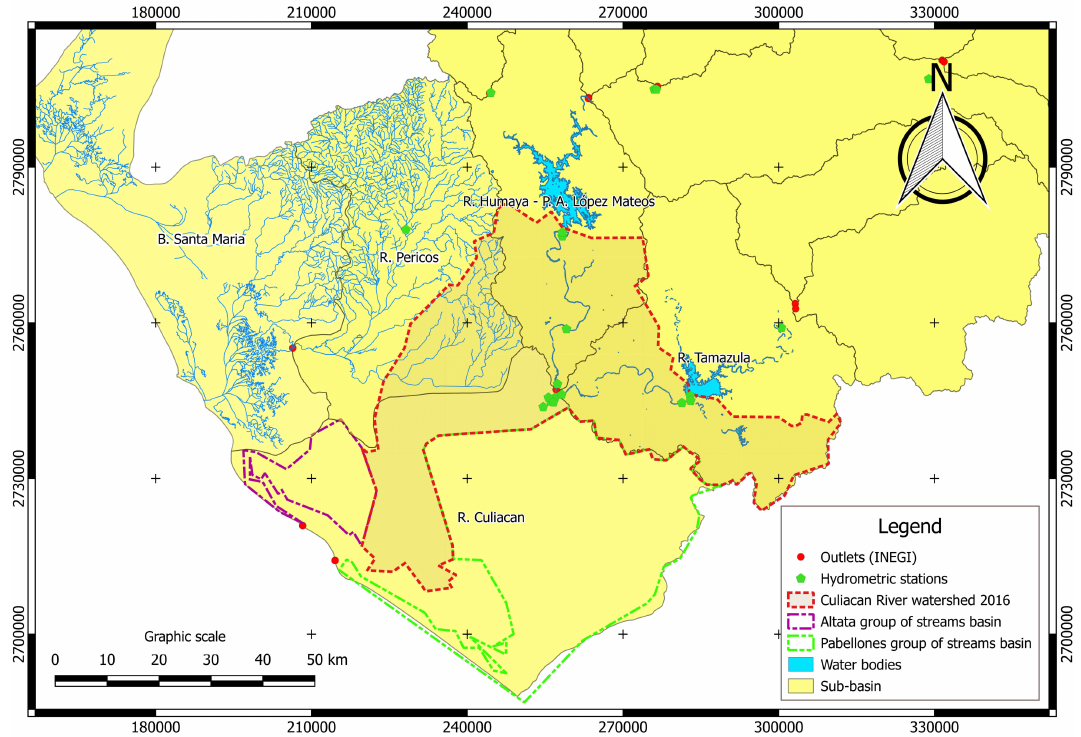
Figure 4. Culiacan River Watershed and Pericos River Basin according to INEGI (2017a); “Pabellones Group of Streams” and “Altata Group of Streams” basins according to CONAGUA (2016a); hydrometric stations and drainage sites obtained from CONAGUA